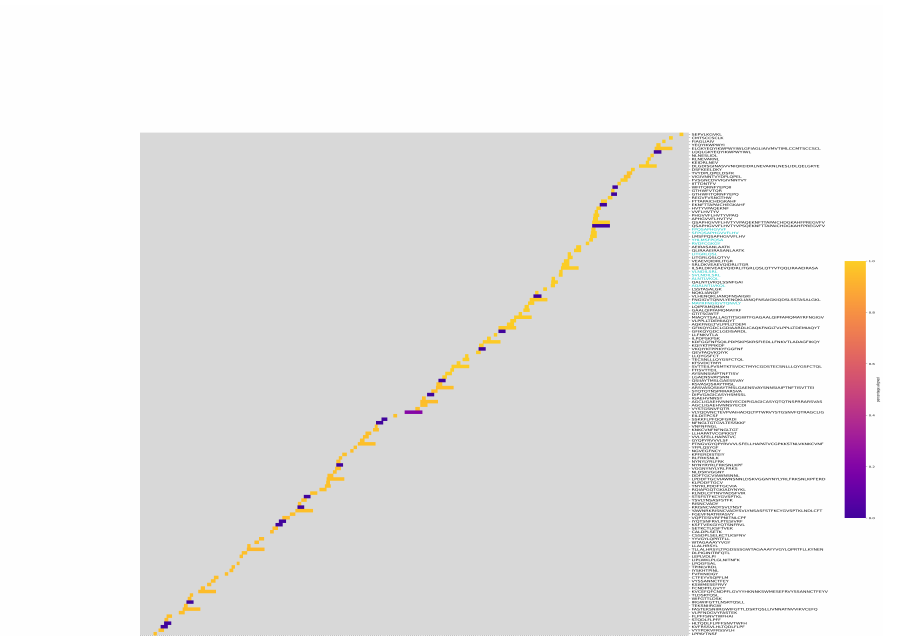
Figure 3. Clustermap obtained after clustering the T cell epitopes of Spike glycoprotein based on the position at which they occur within the protein. The x-axis is the entire length of the protein, which is 1299 in the case of S. Along the y-axis, every row represents one epitope. The color scheme is defined by using a color map that assigns colors to each row depending on occurrences of the epitope across all genomes. The y-axis labels on the right-hand side are colored cyan to indicate an epitope from the top ten list. Data used to generate this figure are present in Supplemental Data